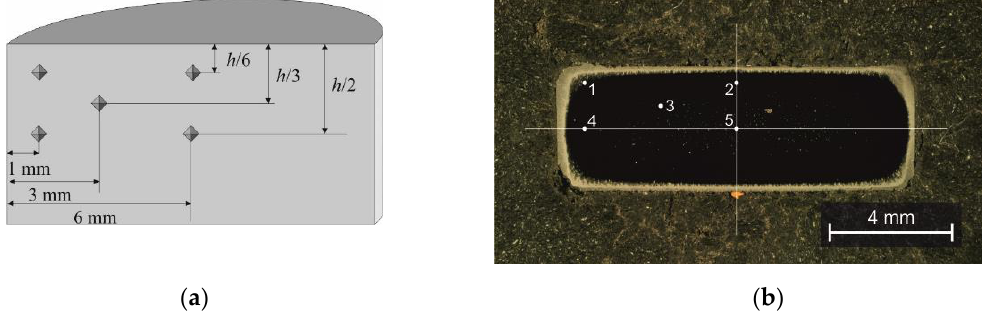
Figure 3. ( a ) Scheme and ( b ) metallographic section of a sintered sample showing the dot pattern where properties were studied.